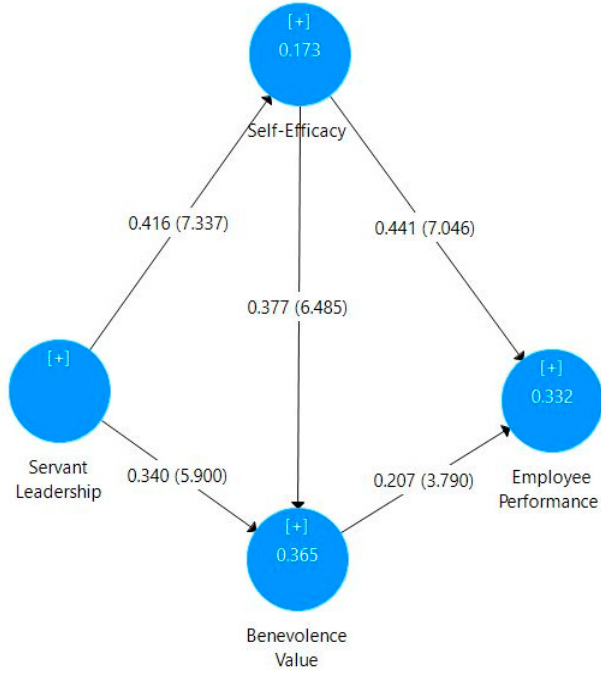
Figure 5. Structural model path coefficient and T values.